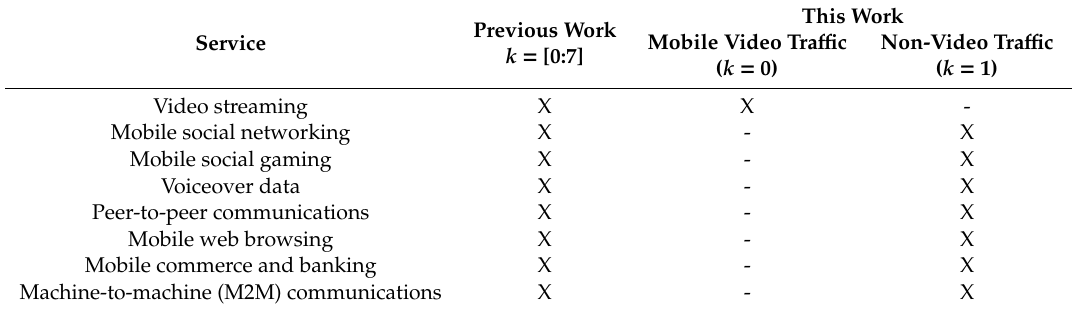
Table 4. Service aggregation.